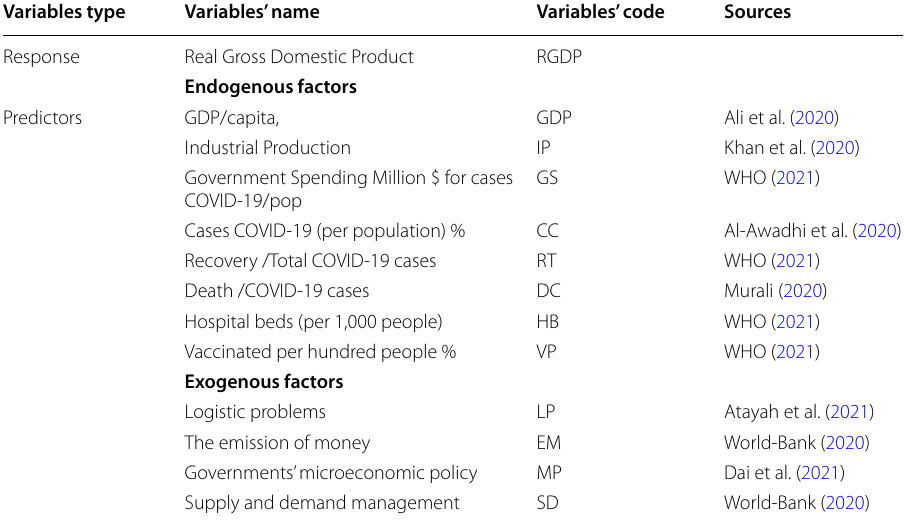
Table 1 Variables, descriptions, and sources of the econometric model Variables